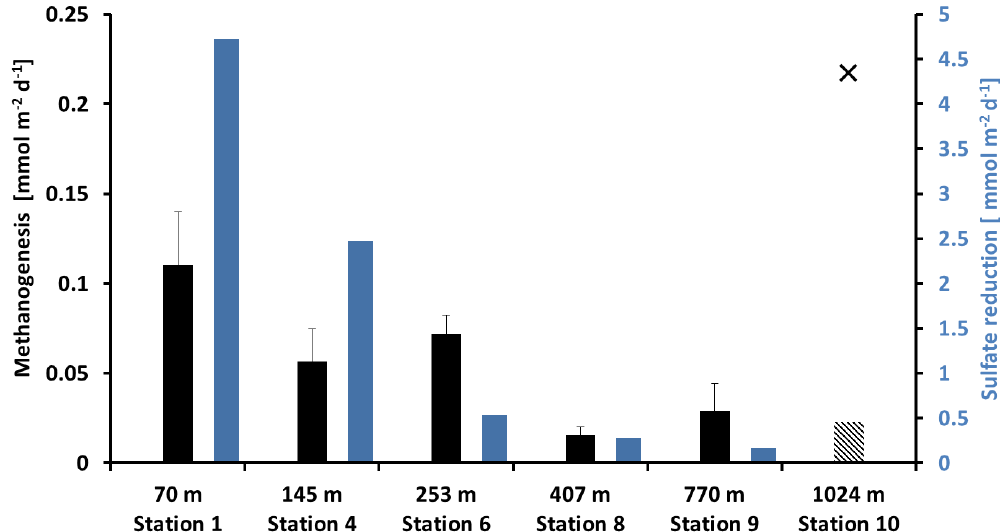
Figure 3. Integrated methanogenesis and sulfate reduction rates (0–25cm) along the depth transect. For methanogenesis rates (black bars), average values are shown with standard deviation. Note for St. 10 a mean from two replicates is shown without standard deviation (pattern- filled bar) and the outlier is shown separately (cross). For sulfate reduction rates (blue bars), means from two replicates are shown without standard